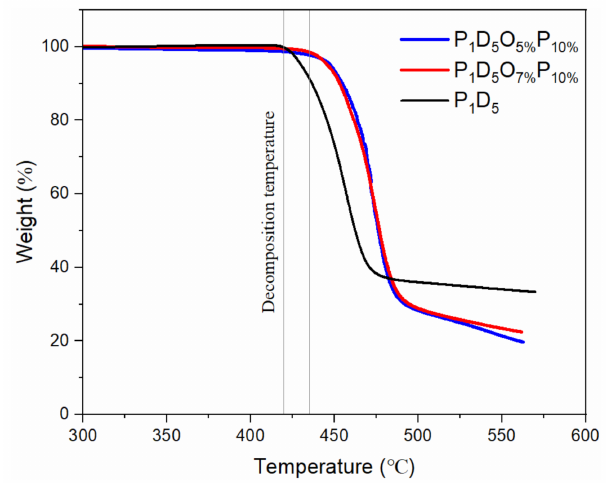
Figure 5. TG curve of the